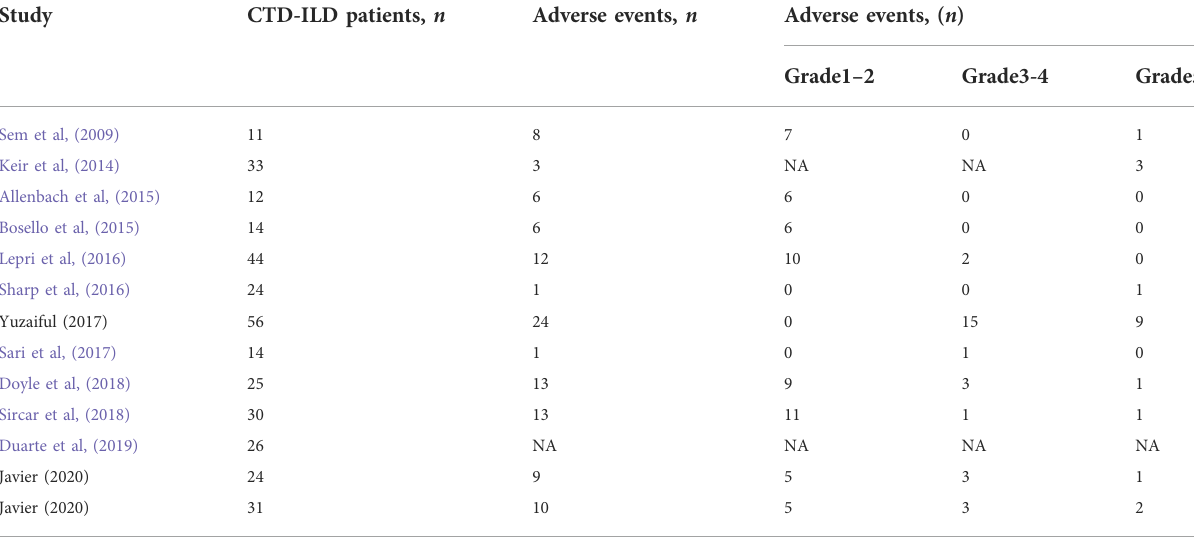
TABLE 3 Adverse events observed after rituximab infusion in CTD-ILD